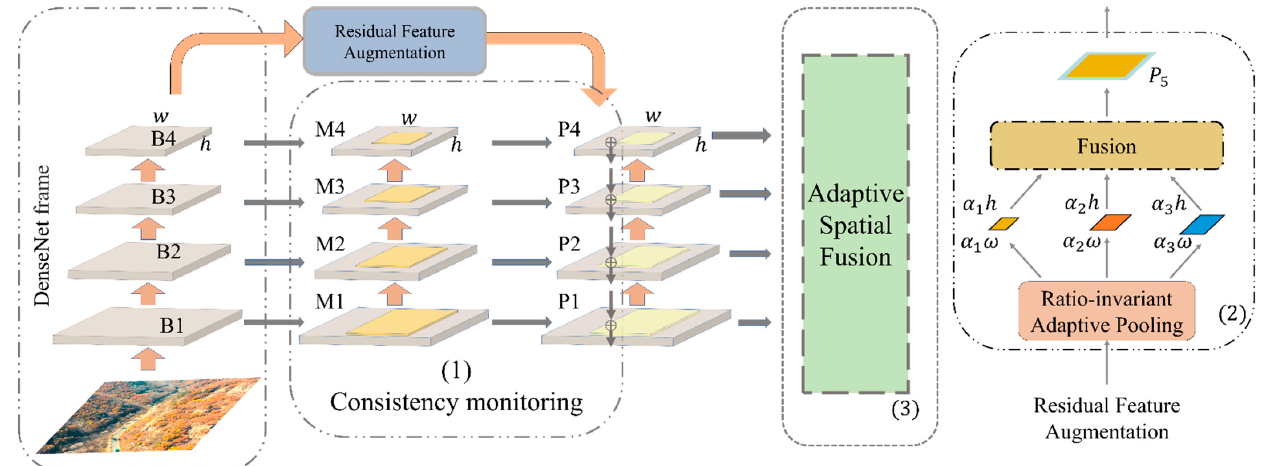
Figure 7. Schematic diagram of AugFPN fusion framework.